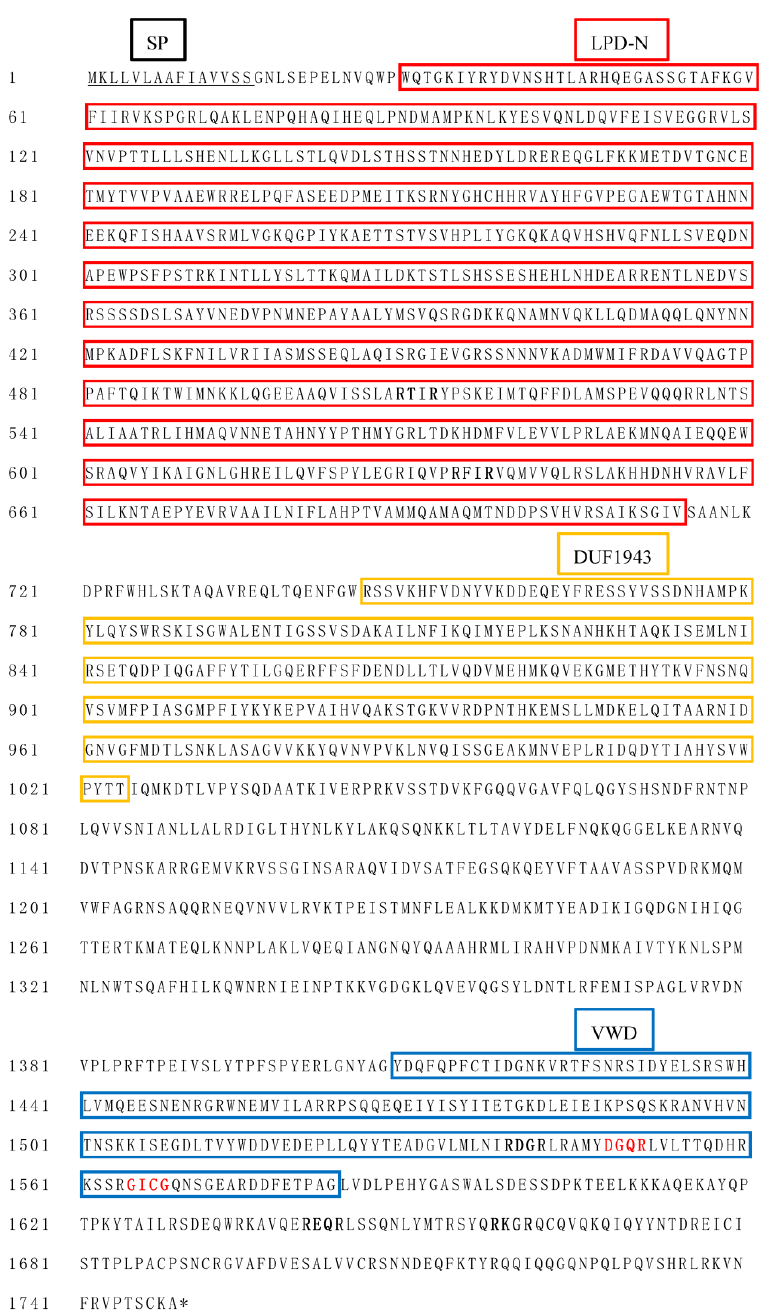
Figure 1. Amino acid sequence alignments of SfVg. Signal peptides are underlined. The domains of LPD_N, DUF1943, and VWD are shown in red, yellow, and blue boxes, respectively. The putative RXXR cleavage sites are shown in bold. The DGQR and GLCG motifs are shown with red letters.